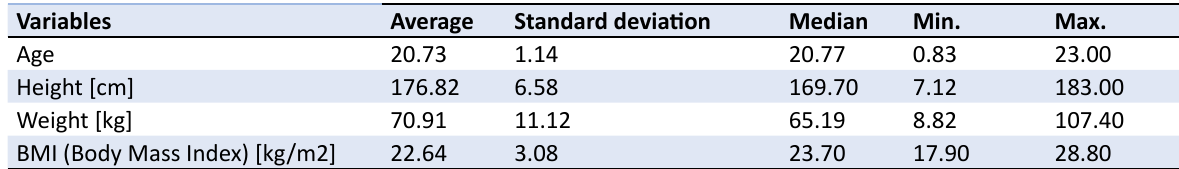
Table 2. Number characteristics of the male students participating in the study